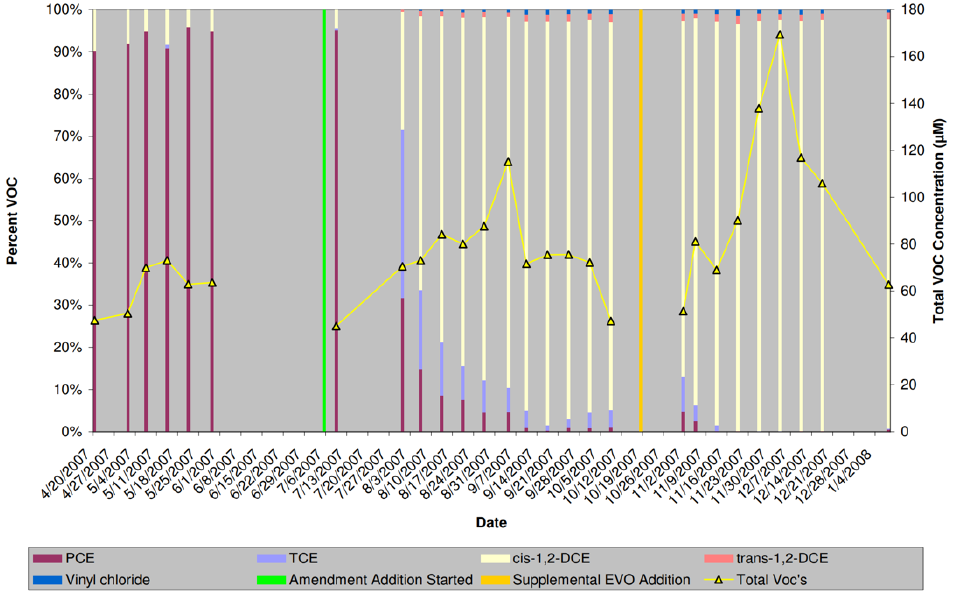
Figure 8. Comprehensive test cell data summary: EVO + hydrogen gas, EW-3% VOC, and total VOC concentration.